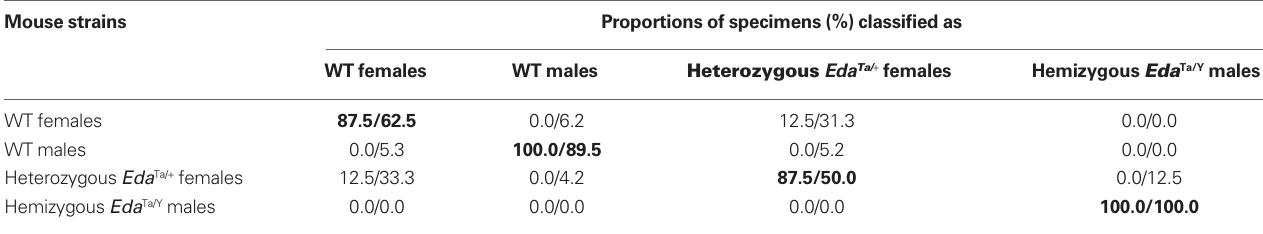
Correct classification of specimens within their own group is indicated in